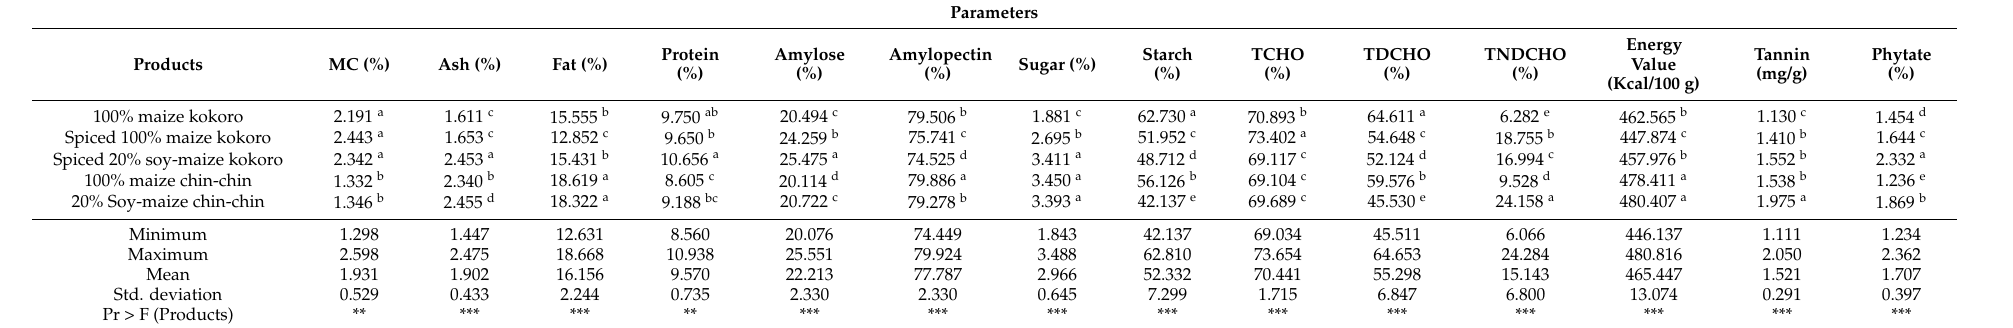
Table 2. Nutritional and Antinutritional properties of deep-fried maize-based